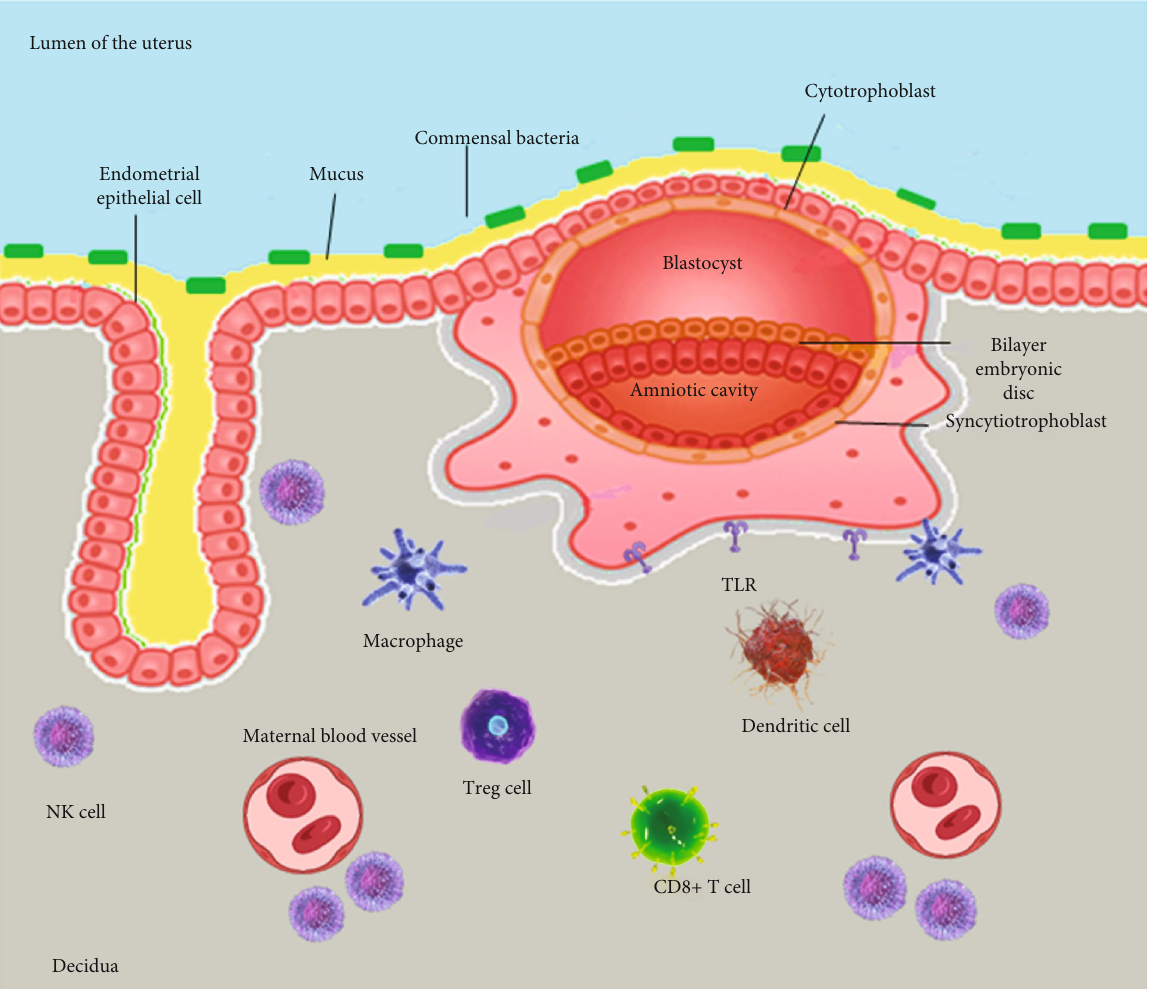
Figure 1: The immune cells around maternal-fetal interface fi gure courtesy,